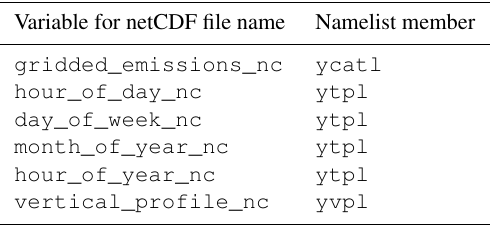
Table 4. Overview of netCDF files and corresponding namelist tags in the TRACER group in INPUT_GHG or INPUT_OAE . The netCDF variable names must be identical to those listed in the namelist members (right